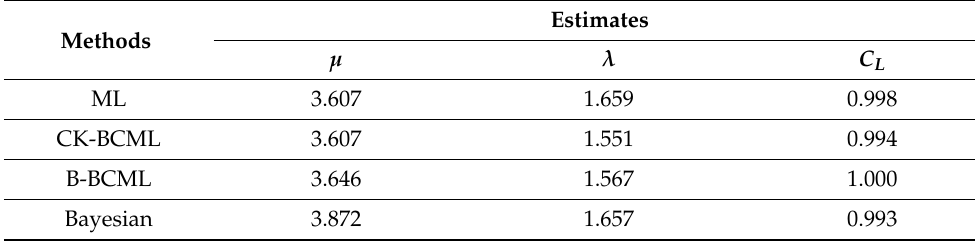
Table 6. The MLEs, CK-BCMLEs, B-BCMLEs and BEs of µ , λ and PPI for L = 0.2.